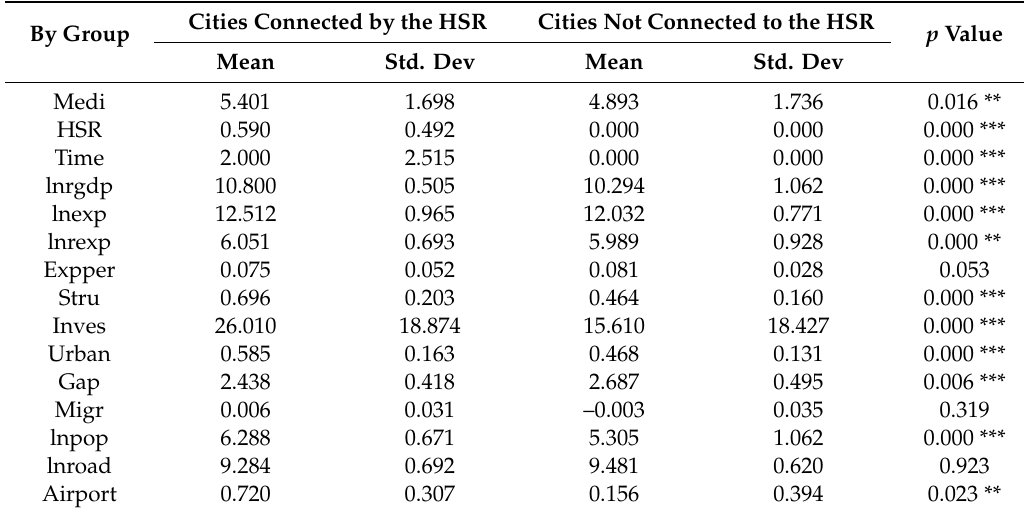
Table 2. Summary statistics by